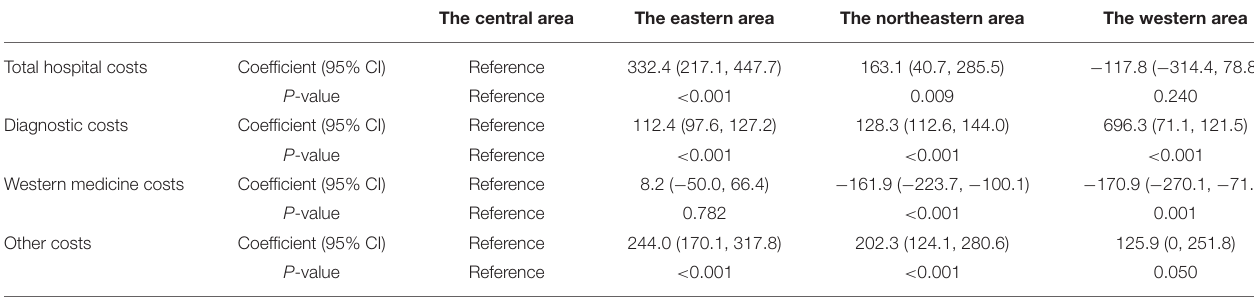
TABLE 2 | Association between regions and each component of hospital costs.